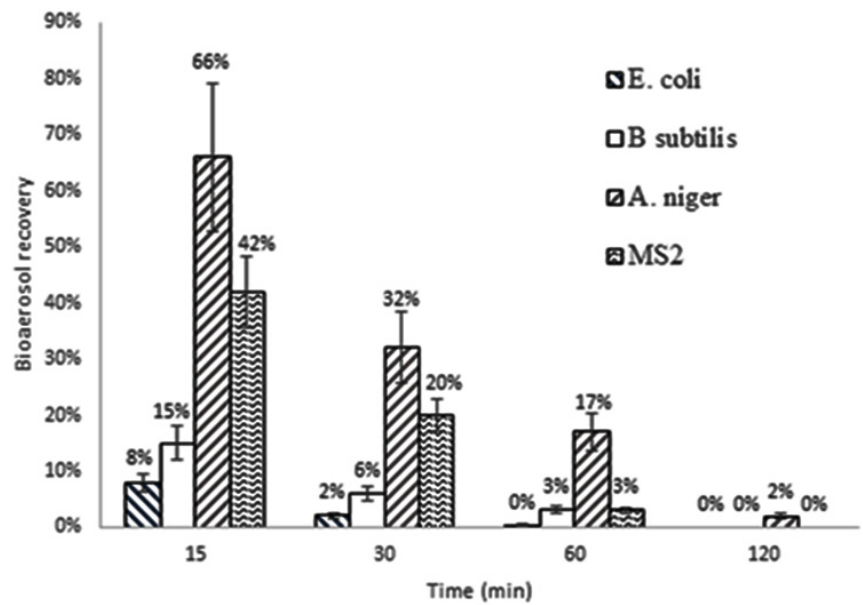
Figure 7. Microbial recovery of E.coli, B.subtilis, A. niger and MS2 aerosols treated with oil blend.